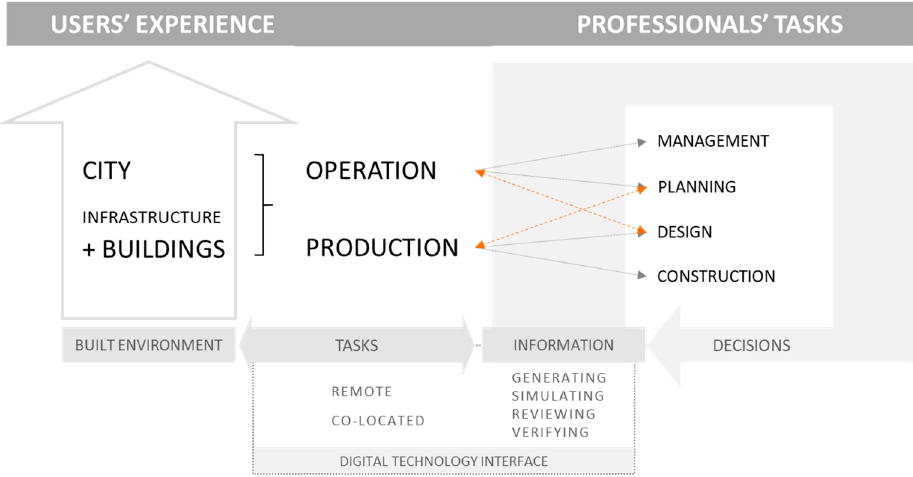
Figure 3. Conceptual view of built environment scales of practice, tasks, and participants.